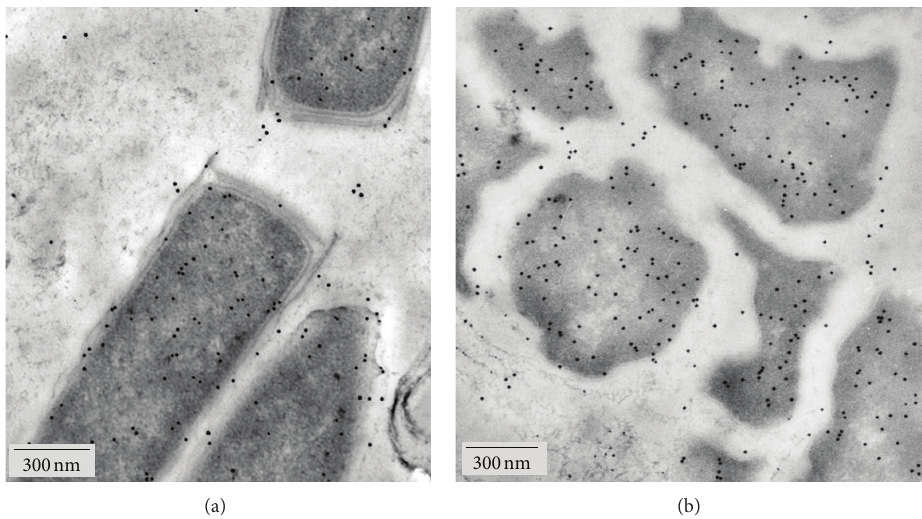
Figure 4: Localization of MCR in predominant morphotypes of microbial mats conducting AOM. Filamentous ANME-1 in the pink layer of the AOM community (a) and coccoid ANME-2 in the black layer (b) exhibit dense cytosolic MCR